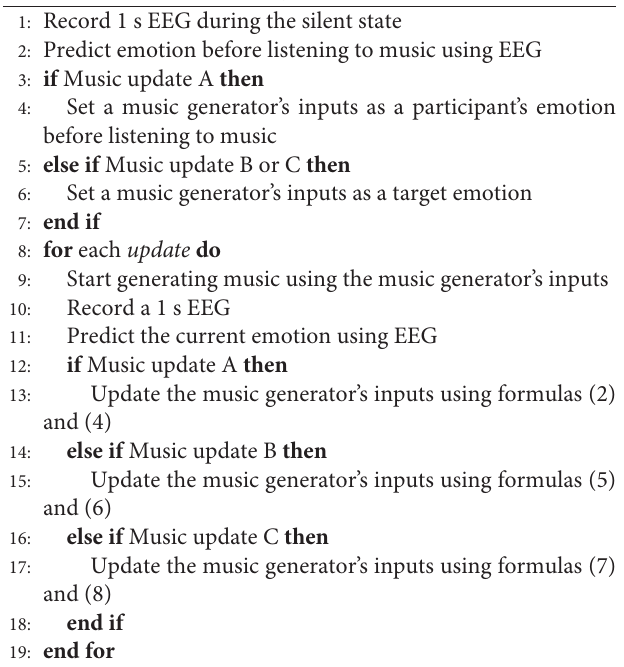
Algorithm 2 : Update music generator’s